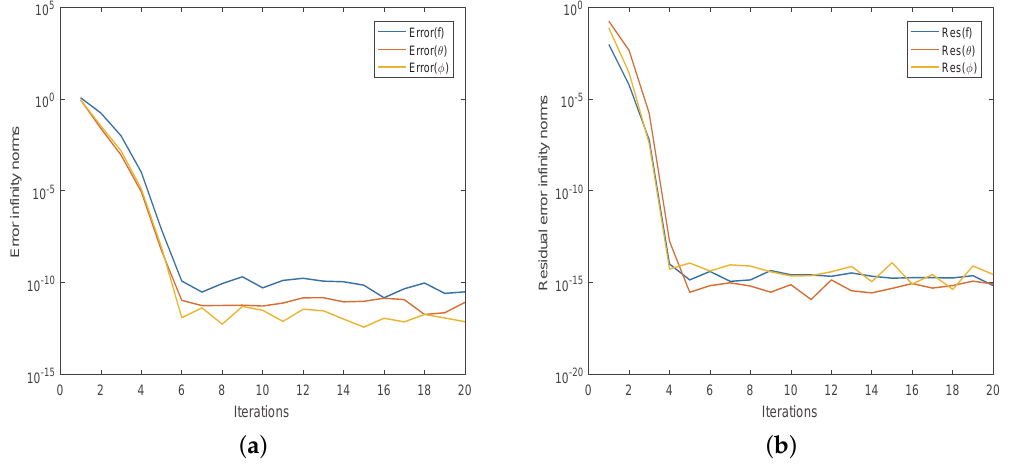
Figure 2. (a) Error infinity norms for f ( η ) , θ ( η ) and φ ( η ) and (b) Residual error infinity norms for f ( η ) , θ ( η ) and φ ( η )